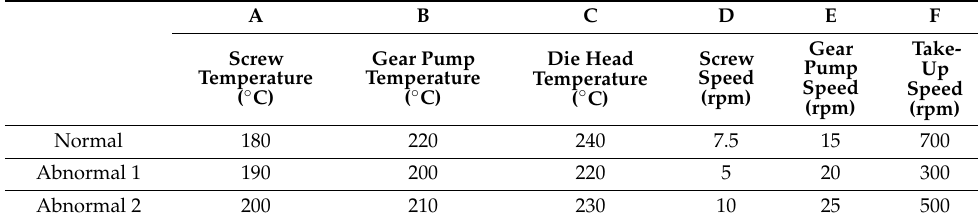
Table 8. Abnormal sample processing parameter